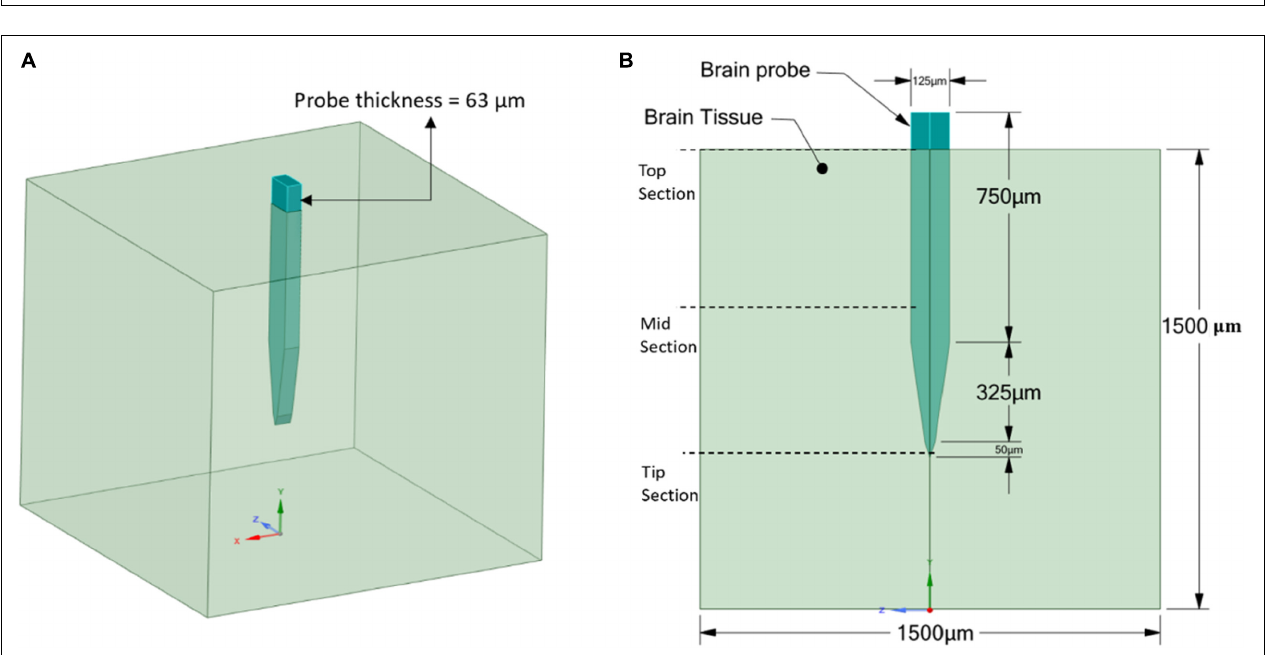
FIGURE 3 | Compliant probe and brain tissue geometrical model and dimensions. (A) 3D view; (B) 2D front view.